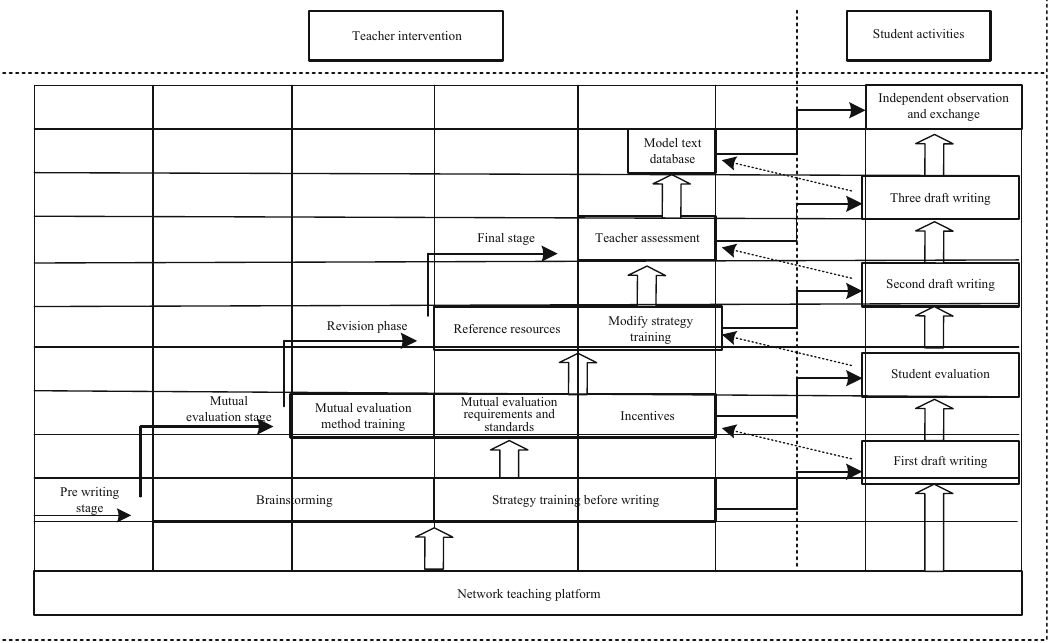
Figure 4: Optimization of college English writing assessment process.